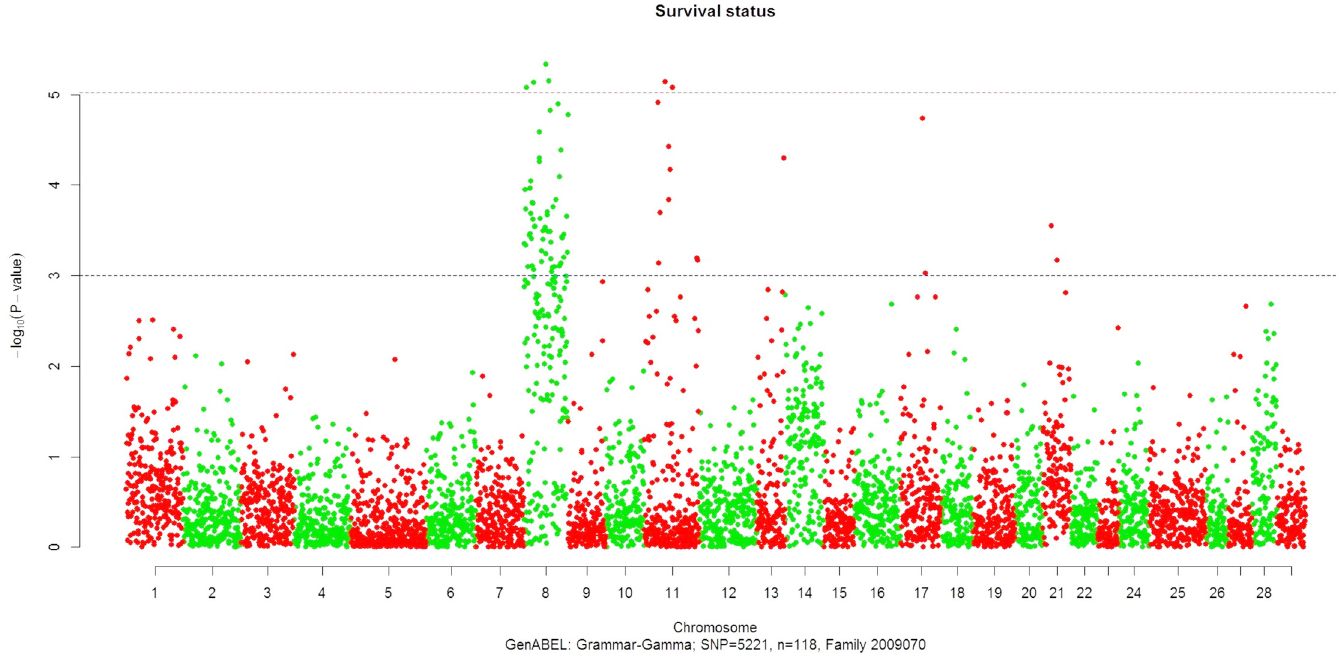
Fig 1. Results of GWAS for the survival status phenotype recorded post-infection with Flavobacterium psychrophilum in rainbow trout family